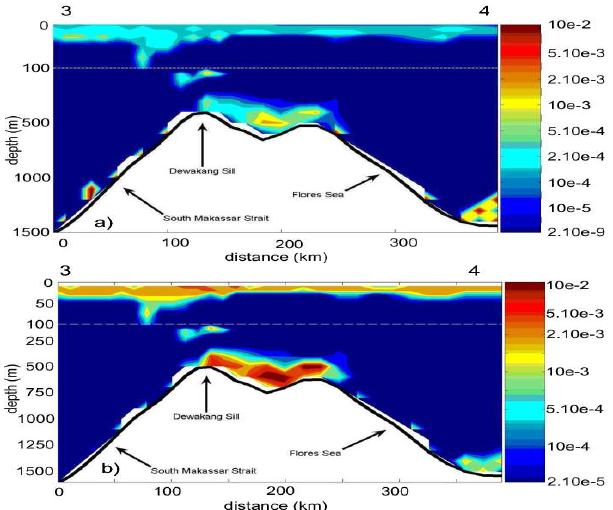
Fig. 3. Sections of (a) q 2 (m 2 s − 2 ) and (b) K M (m 2 s − 1 ) through the Dewakang Sill. Locations of points 3 and 4 at the top of the figures are given in Fig. 1.